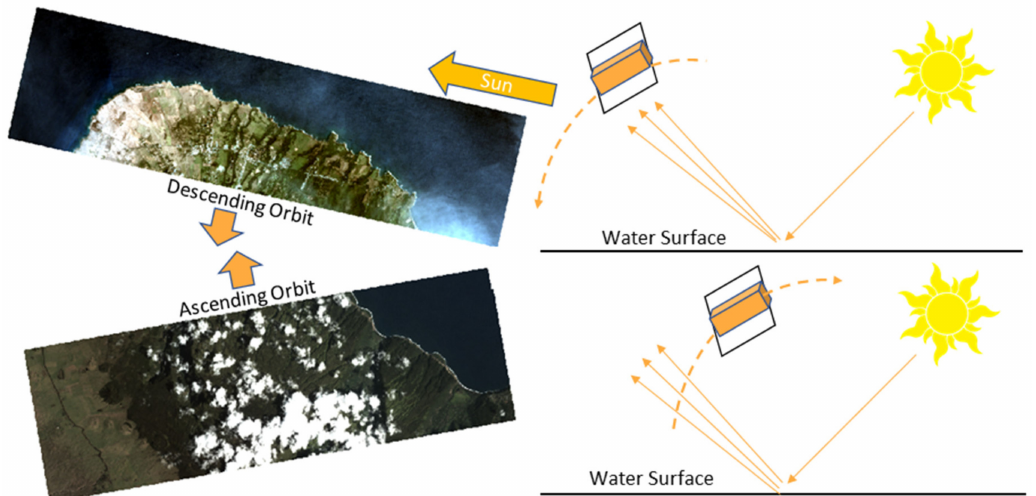
Figure 4. The ascending versus descending orbits perform di ff erently with respect to the amount of sunglint a ff ecting pixel brightness. Separating the usage of orbits helped to reduce the variation caused by